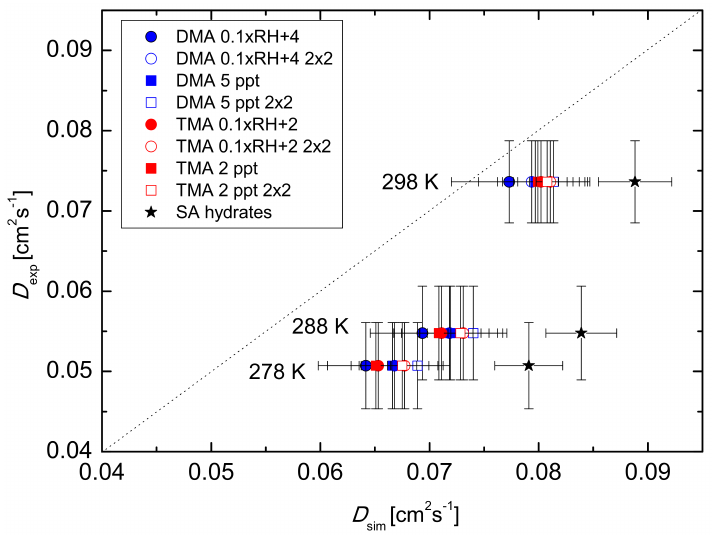
Figure 6. Comparison of the experiment and the cluster population simulations at different temperatures, considered are also different levels and sources of impurities in the system. The formation of clusters containing up to two H 2 SO 4 and two base molecules is denoted as “2 × 2” in the